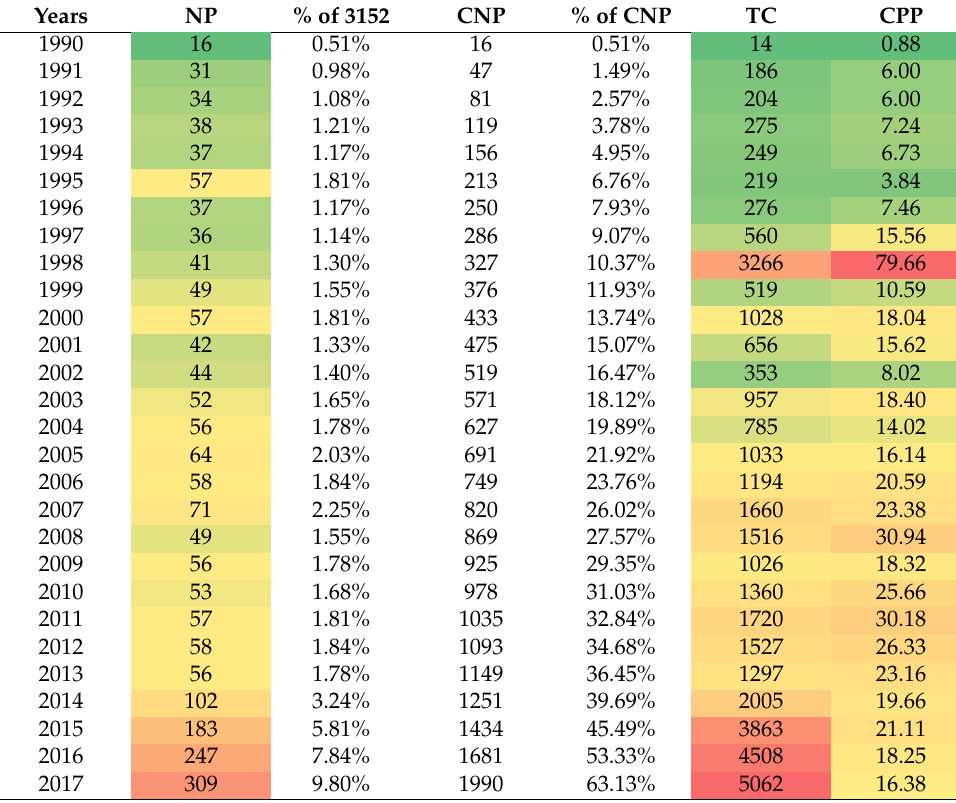
Figure 2. The number of publications in each year of PSEP from 1990 to 2020 in Web of Science. Table 1. Annual publications and citations of PSEP.